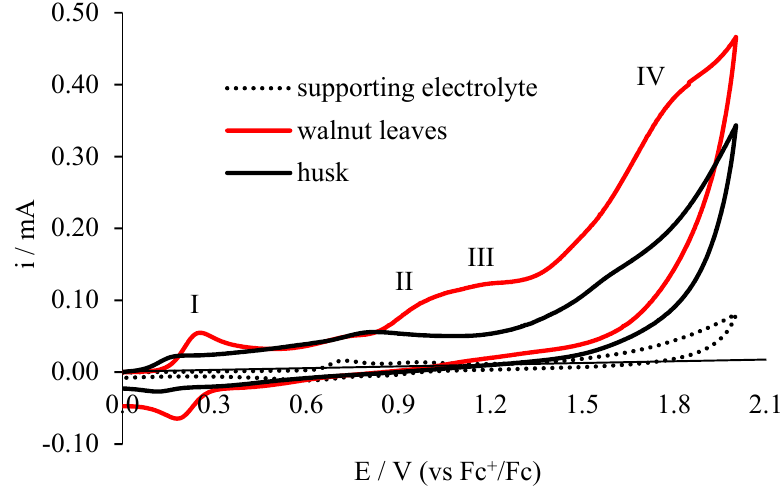
Figure 4. Cyclic voltammetry (CV) electrooxidation of leaf extracts and walnut husks on the electrode Pt; c = 20 mg / dm 3 in 0.1 M (C 4 H 9 ) 4 NClO 4 in acetonitrile, v = 0.1 V / s.